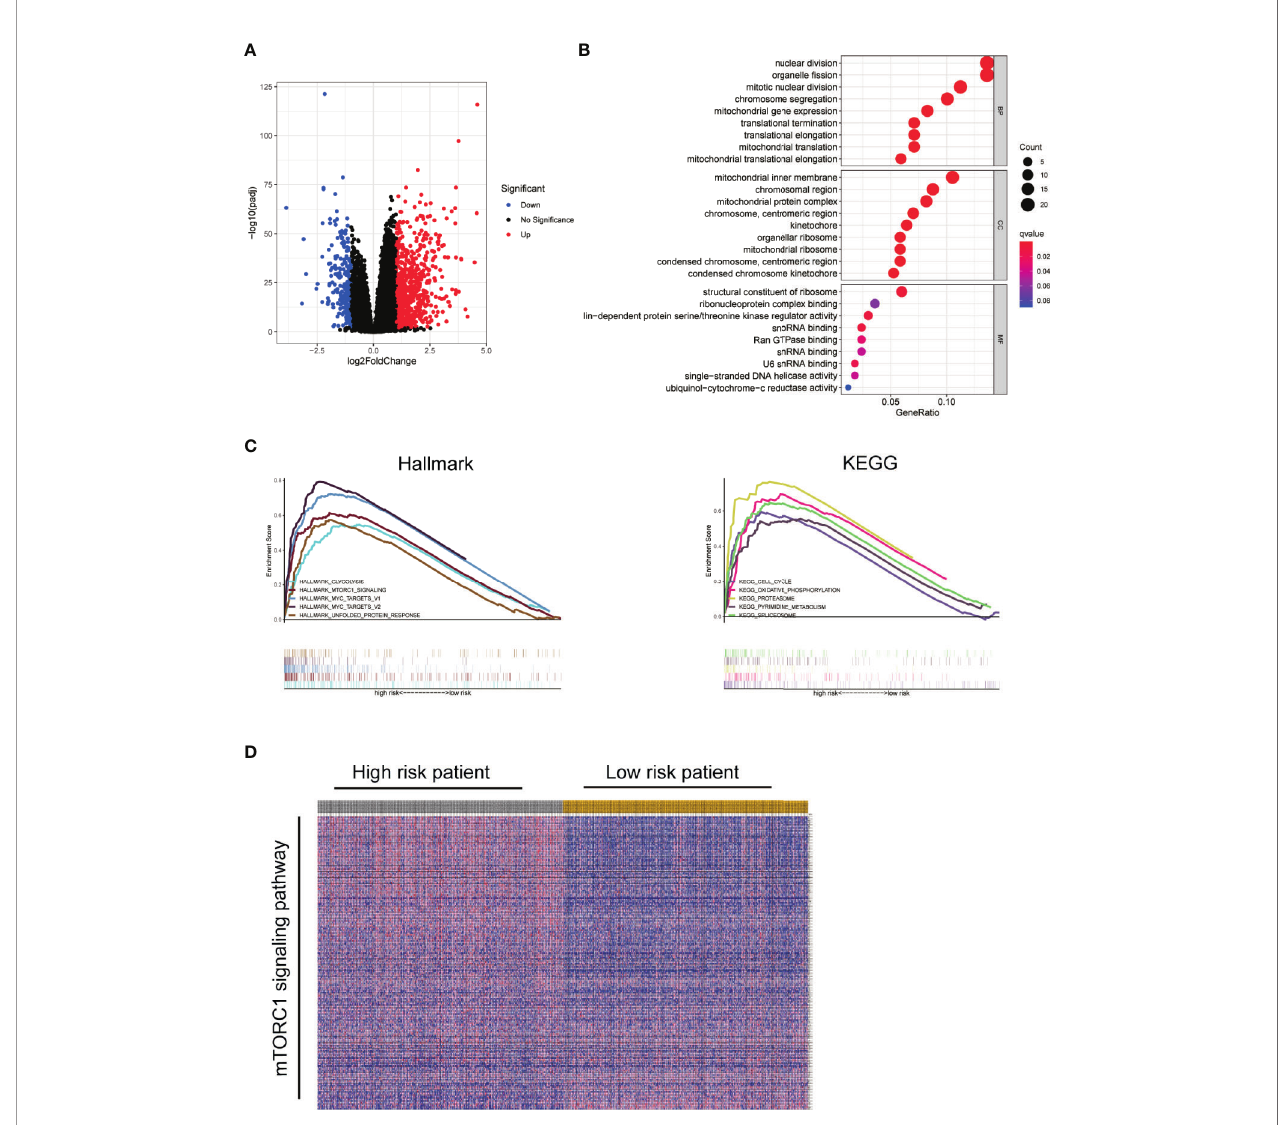
FIGURE 6 | Functional enrichment. (A) Volcano plot showed DEGs between high-risk and low-risk group using TCGA data. (B) Bubble diagram of enriched GO using top 200 DEGs. (C) GSEA comparing the high- and low-risk groups. (D) Visualization of mTORC1 signaling pathway genes in high- and low-risk groups by